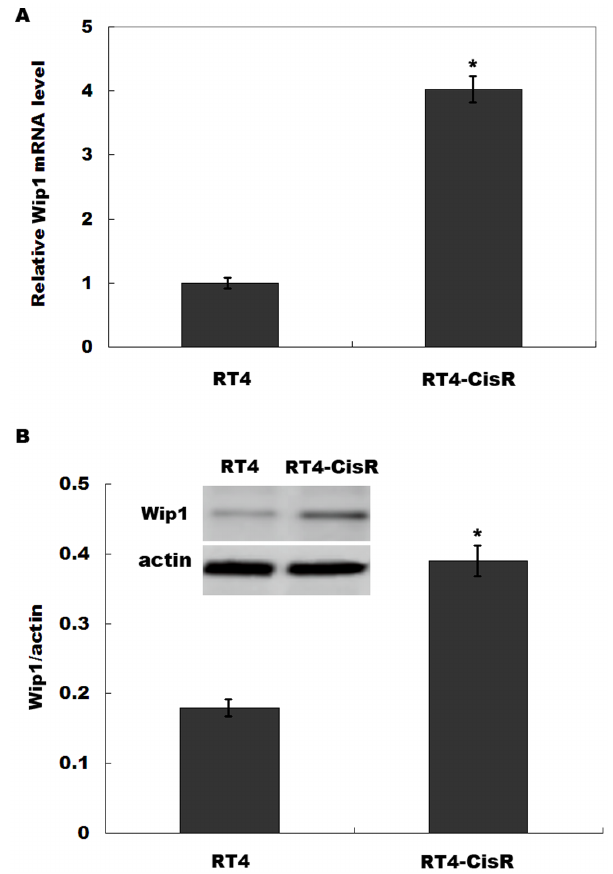
Figure 3. Wip1 expression is upregulated in RT4-CisR cell compared with RT4 cell. (A and B) Wip1 mRNA and protein expression levels were assayed in RT4 and RT4-CisR cells, respectively. * p ,